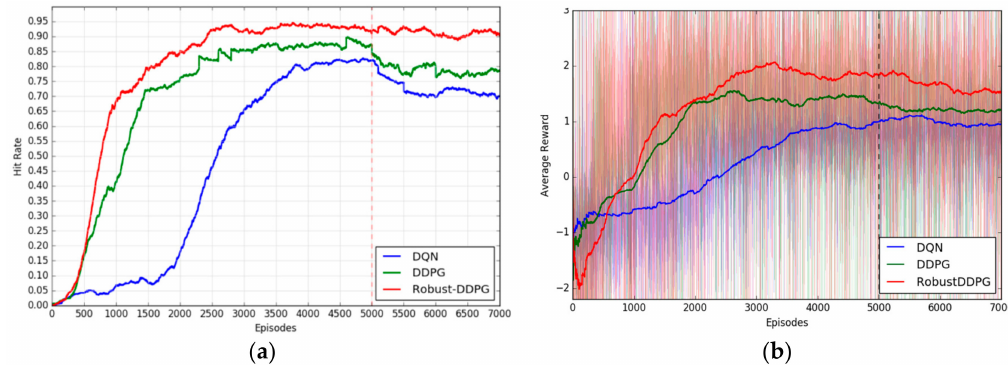
Figure 7. Convergence curves of Deep Q Network (DQN), Deep Deterministic Policy Gradient (DDPG), and Robust Deep Deterministic Policy Gradient (Robust-DDPG). ( a ) Hit rate trends with respect to training episodes; ( b ) Average reward trends with respect to training episodes.